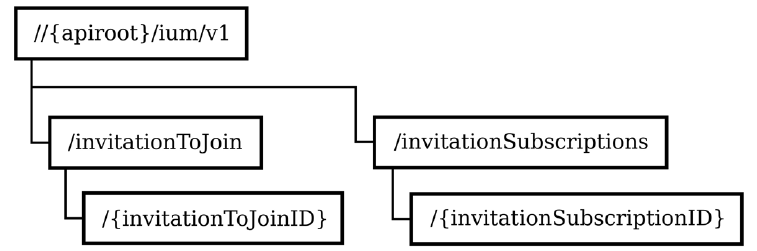
Figure 8. Resource URI structure of the IUM service.